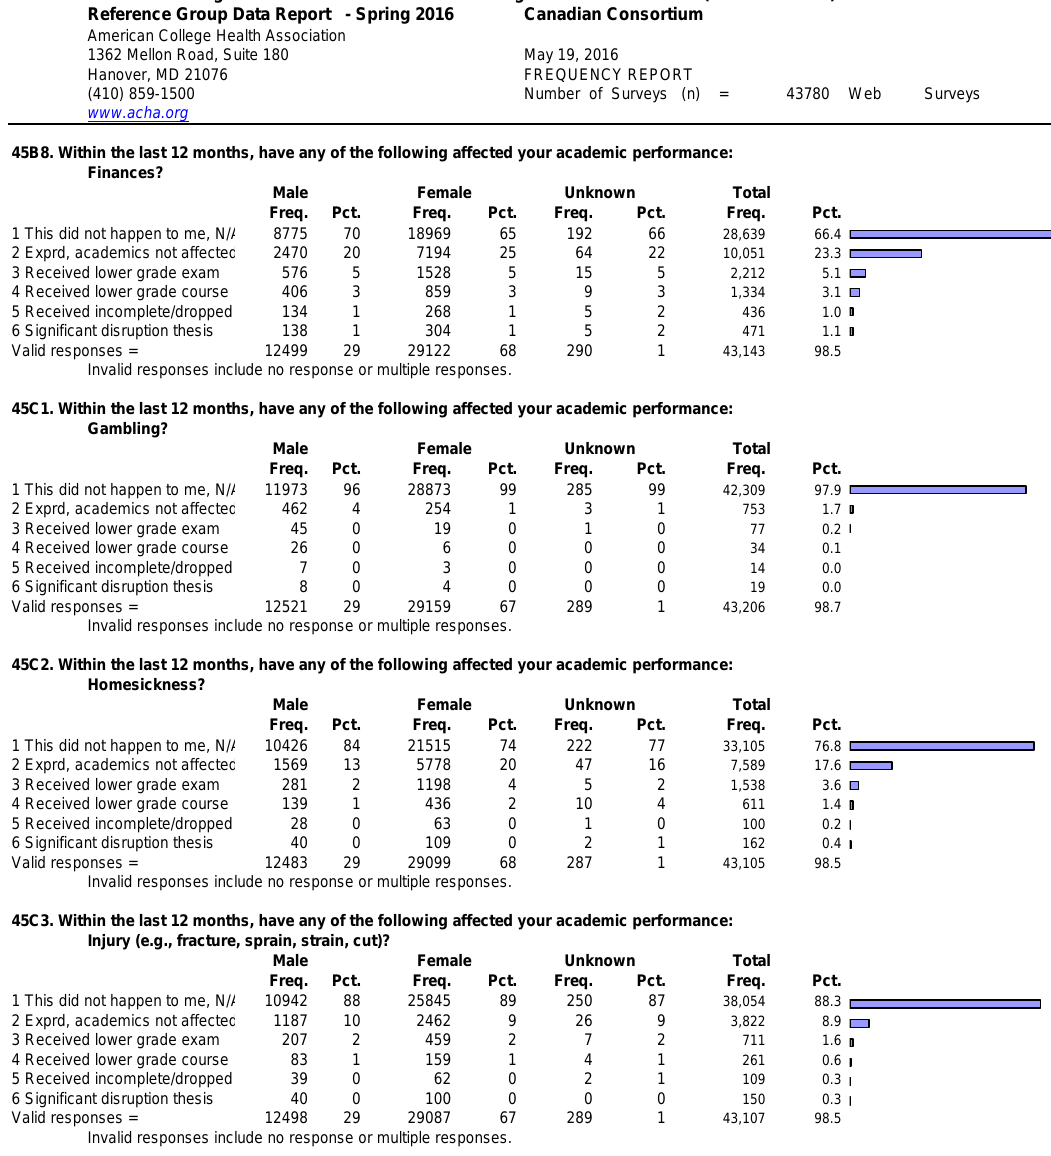
Invalid responses include no response or multiple